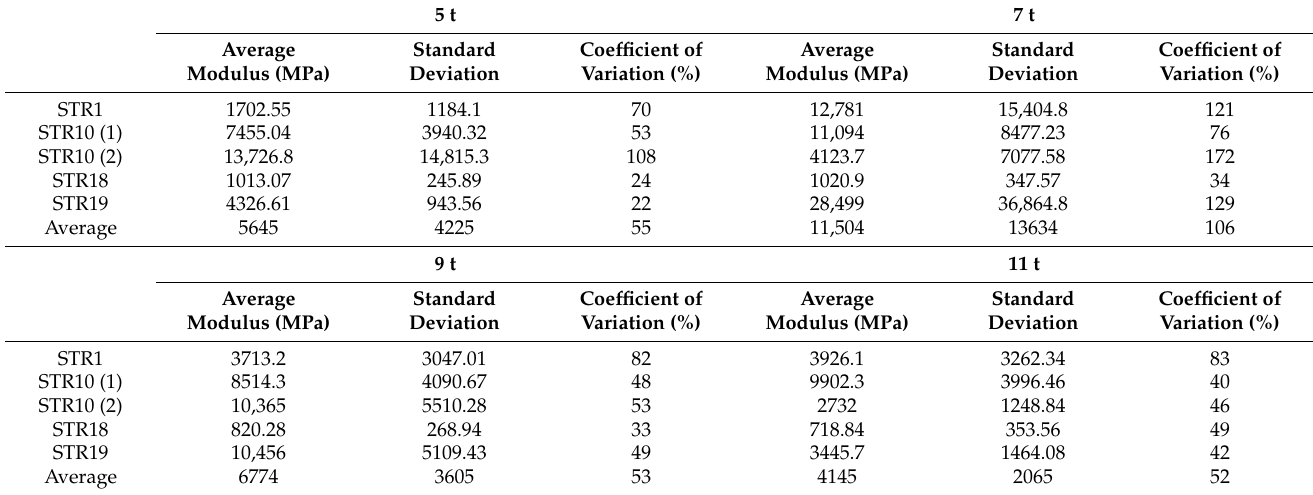
Table 7. The modulus back calculation results of middle layer.